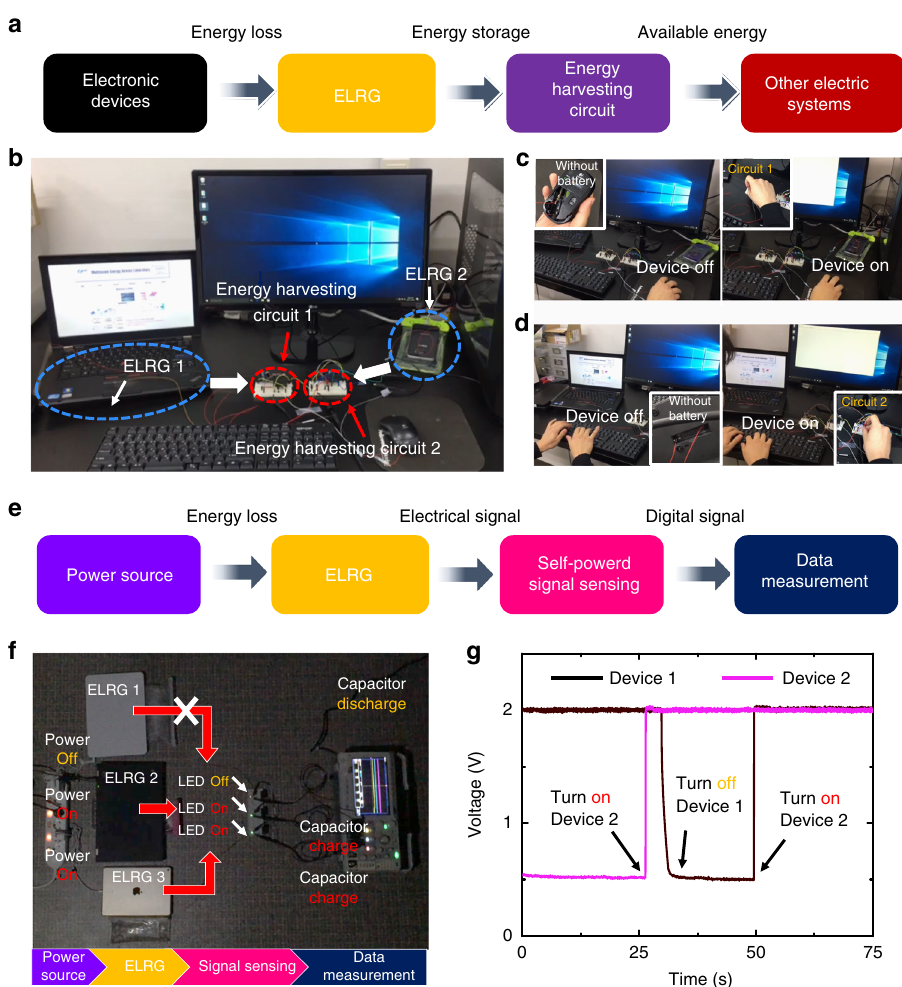
Fig. 6 ELRG is applicable in our everyday environment. All electric devices are plugged into a 60-Hz AC input electrical source. Detailed electric outputs are given in Supplementary Figs. 8 – 9. a Integration of ELRG in individual connection for constructive energy-harvesting. b Optical picture of the integrated ELRG system. Two ELRG outputs are connected to an energy-harvesting circuit (from cell phone and laptop). c Discharged Bluetooth mouse is operated by a connected energy-harvesting circuit. d Discharged Bluetooth keyboard is operated by the connected energy-harvesting circuit. e Schematics illustrating self-powered wire-sensing conformation. f Optical picture of the self-powered wire-sensing ELRG system. Three ELRG outputs are detected by capacitor circuits and LEDs. g Plots showing electric potential variation in the connected